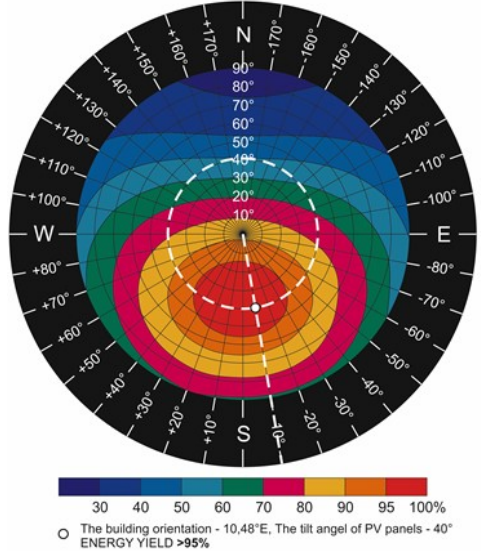
Figure 7. The effect of the building orientation and the tilt angle of PV panels on the percentage of energy yield (own work based on [49]).